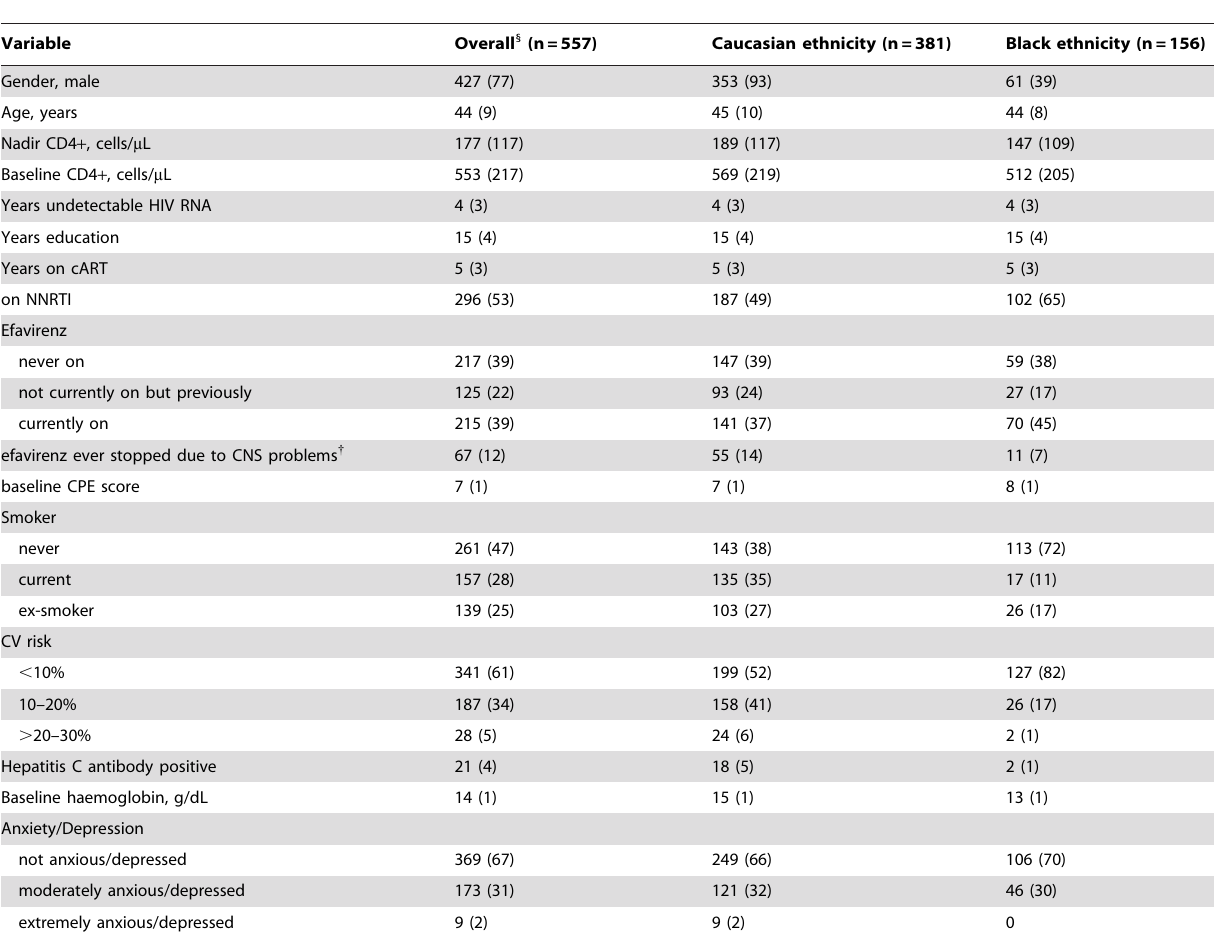
Table 1 legend : 1 only patients with complete neurocognitive data (including patients of ethnicity other than Caucasian or Black, n=20); { 5/67 (all Caucasian) were back on efavirenz at baseline; cART = combination antiretroviral therapy, CPE = Clinical Penetration Effectiveness, CV = cardiovascular, NNRTI = non-nucleoside reverse- transcriptase inhibitor; Data are number (%) or mean (standard deviation).